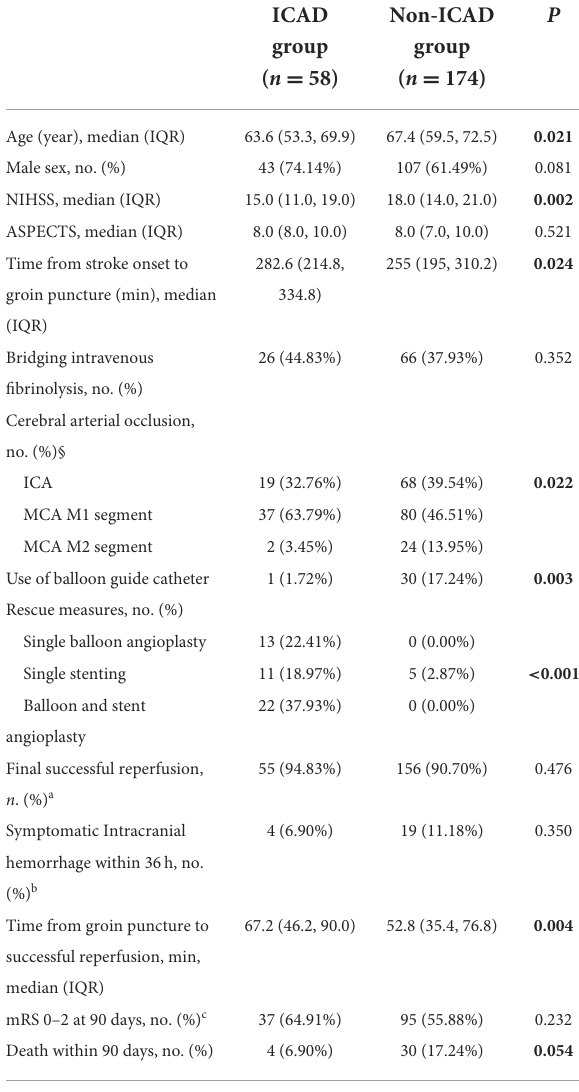
TABLE 3 Baseline, clinical, and angiographic results in subgroup